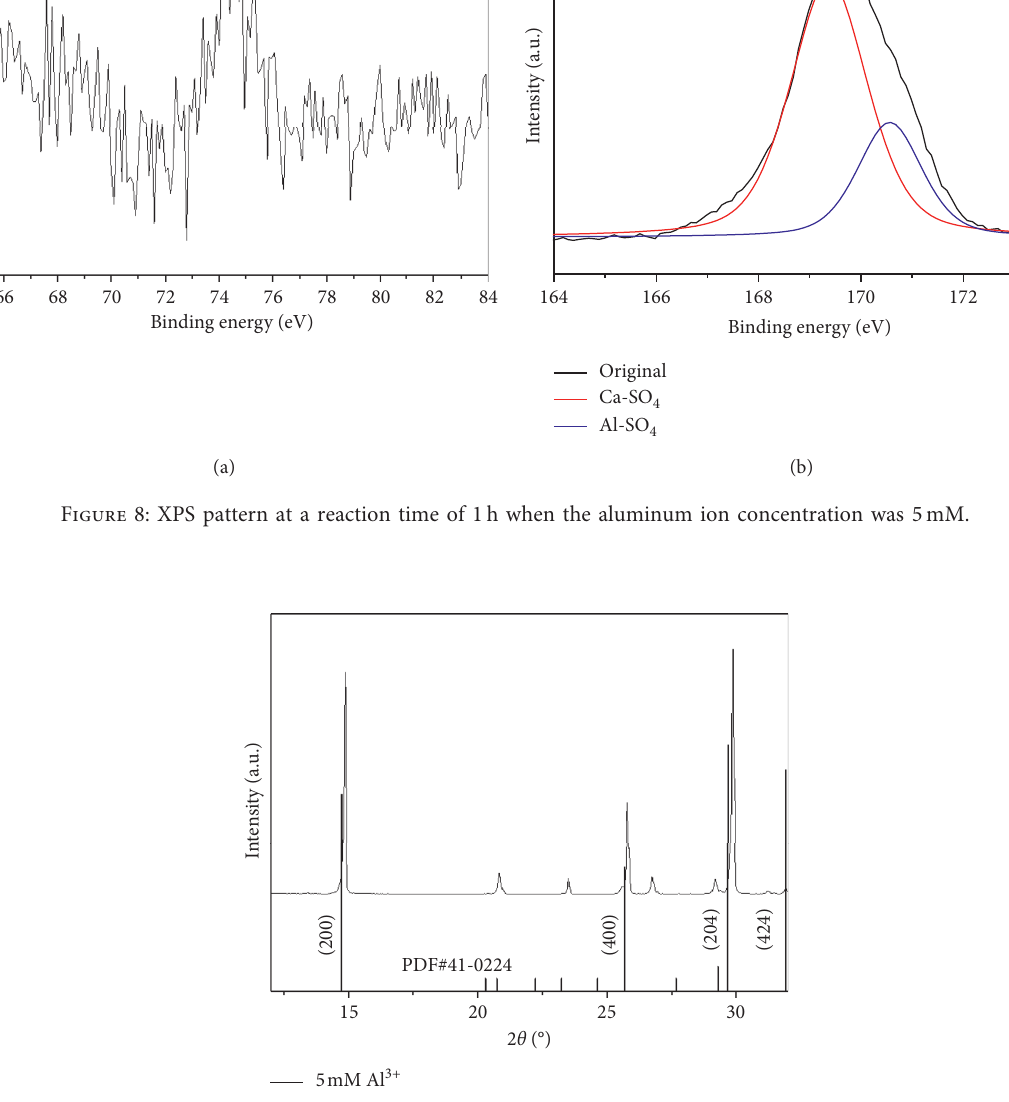
Figure 9: XRD pattern at a reaction time of 1h when the aluminum ion concentration was